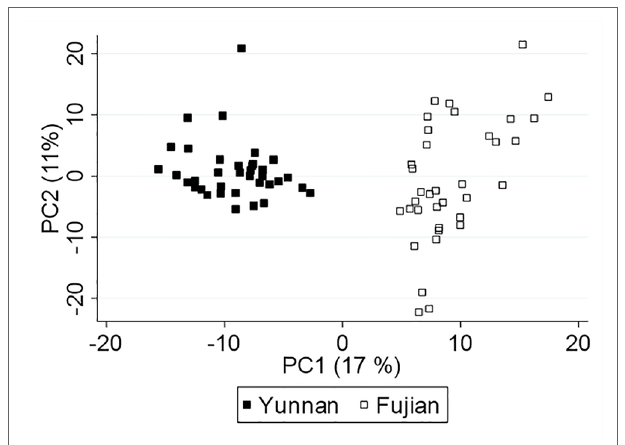
FIgURE 2 | Principal component analysis (PCA) score plot of Yunnan and Fujian tea.